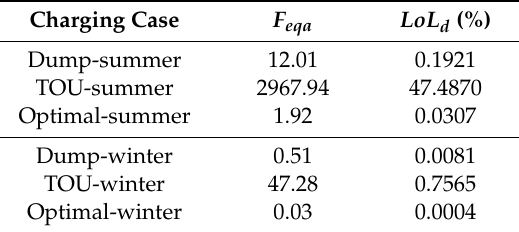
Figure 9. Correlation of the transformer loss of life ( LoL d ) and the transformer winding hottest-spot temperature (HST) in summer ( a ) and winter ( b ). Table 5. Transformer aging evaluation .